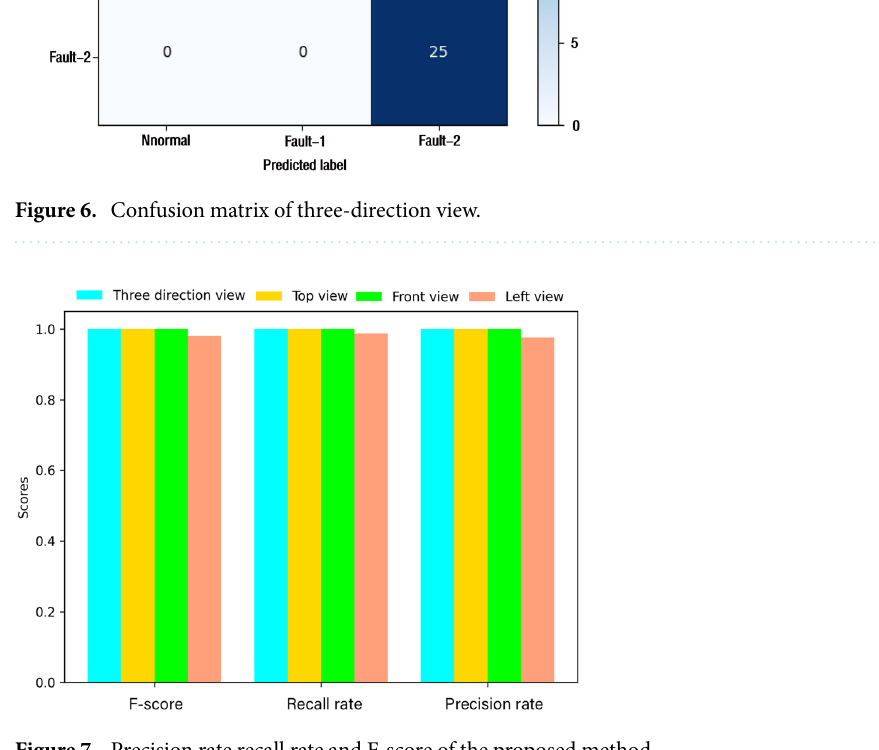
Figure 7. Precision rate,recall rate and F-score of the proposed